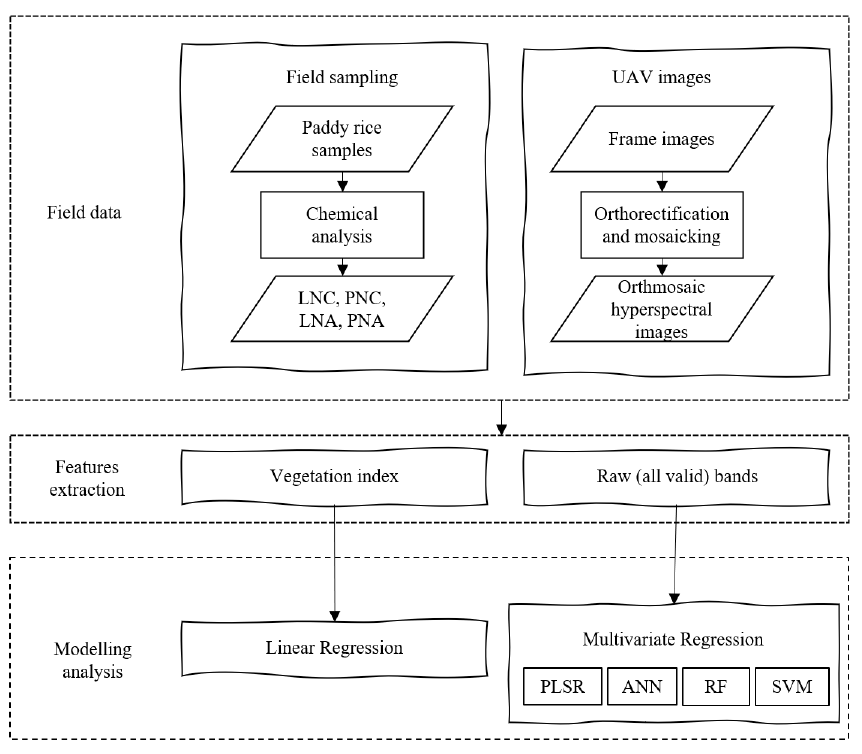
Figure 2. General workflow of this